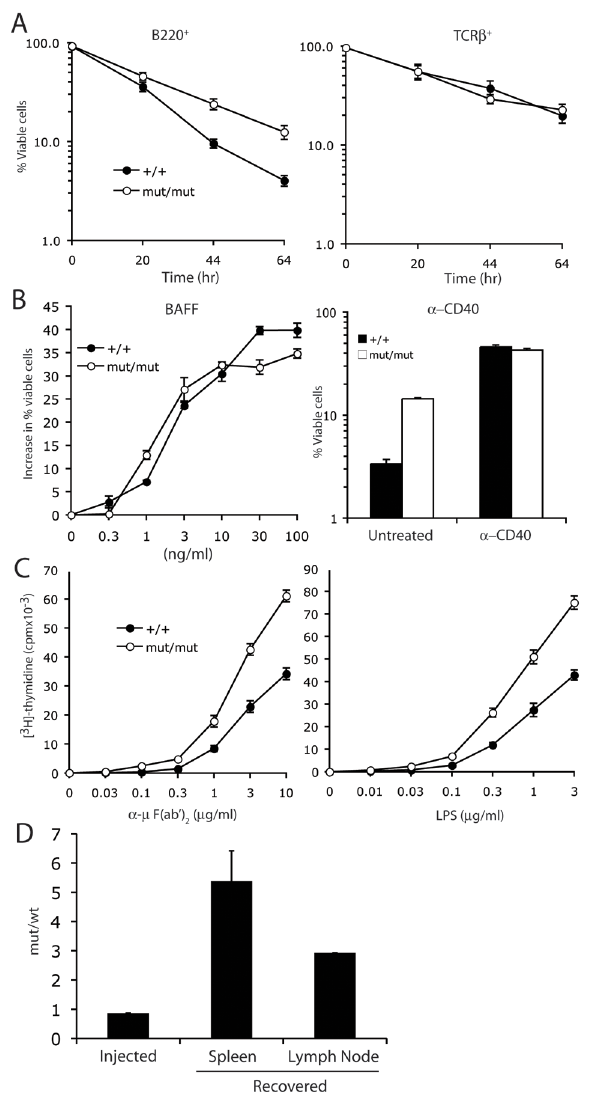
Figure 6. c-IAP2 H570A/H570A B cells are more sensitive to proliferative stimuli and survive longer in vitro. (A) Splenocytes from wild type and c-IAP2 H570A/H570A mice were cultured for the indicated times and the percentage of viable B and T cells was quantitated by staining with anti-B220, anti-TCR b , and 7AAD. The experiment was performed in triplicate and the error bars represent the standard error of the mean. (B) Purified B cells were incubated with or without BAFF or agonistic anti-CD40 for 66 h and cell viability was determined as in (B). For the assessment of BAFF sensitivity, the percent viability of untreated cells was subtracted from the percent viability at each concentration of BAFF and the results are displayed as the increase in percent viable cells. (C) IgM- and LPS-induced proliferative responses of wild type ( + / + ) and c-IAP2 H570A/H570A (mut/mut) B cells. Purified B cells were cultured in vitro with the indicated concentrations of anti- m (Fab 9 ) 2 or lipopolysaccharide (LPS) for 48 h, pulsed with 3 H-thymidine, and harvested 18 h later. The experiment was performed in triplicate and the error bars represent the standard error of the mean. (D) Adoptive transfer of equal numbers of splenic wild type (wt; CD45.1 + ) and c-IAP2 H570A/H570A (mut; CD45.2 + ) B cells into RAG2-deficient mice. Forty-five days later splenocytes and lymphocytes were prepared and the ratio of mut/wt B cells recovered was calculated by dividing the percentage of mut (B220 + CD45.2 + ) cells by the percentage of wt (B220 + CD45.1 + ) cells.